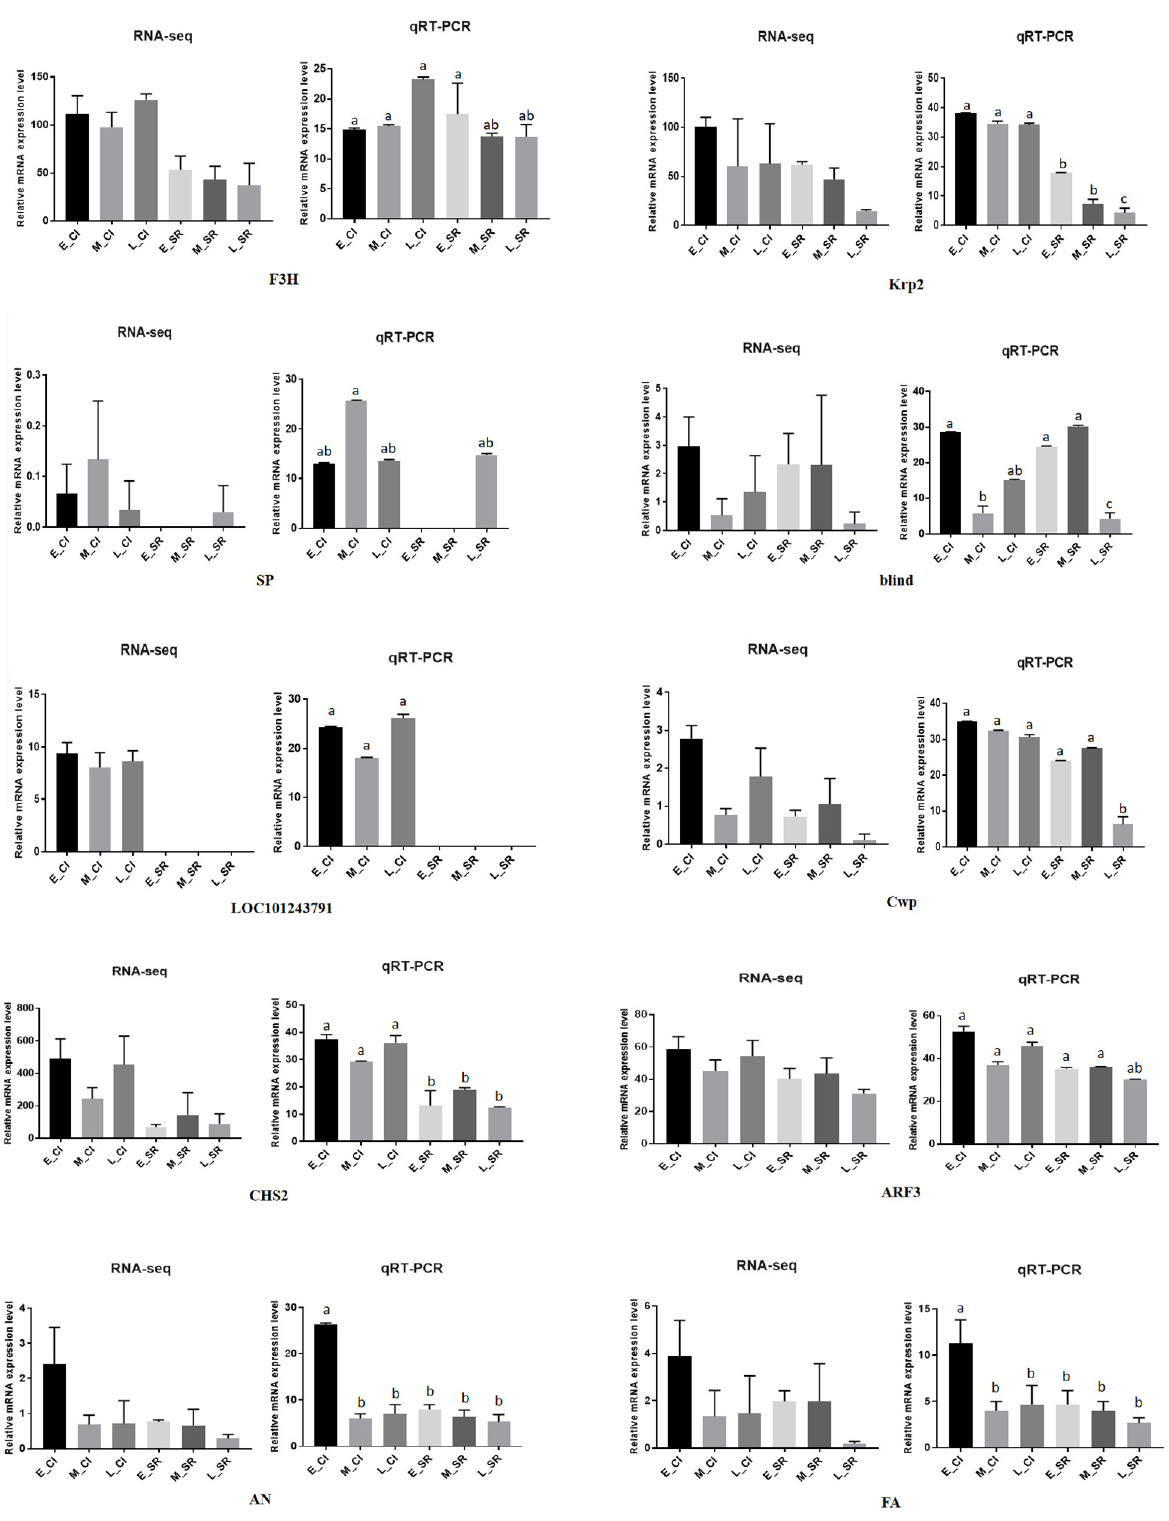
Figure 8. Comparative analysis of expression results between RNA-Seq and qRT–PCR for 10 DEGs. Three technical replicates were performed for each biological replicate of each sample. Error bars represent standard deviation. p < 0.05 means significant difference: a was significantly higher than b and c; b was significantly higher than